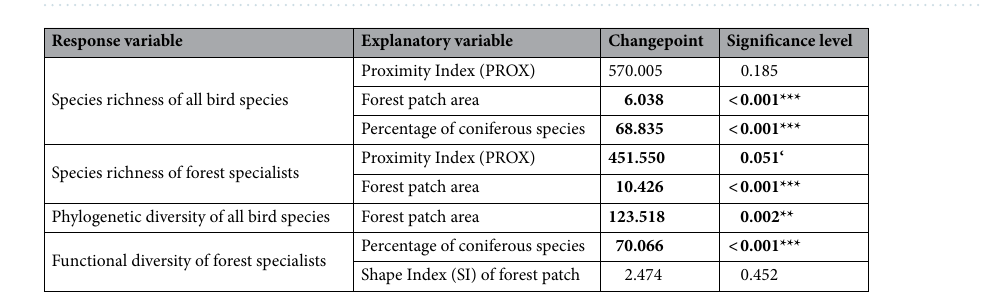
Figure 3. Response curves, derived from General Additive Modelling, showing the relationship between different metrics of bird diversity (for all of the study species and forest specialist group) and the amount of forest patches calculated for 2-km buffer (PROX).